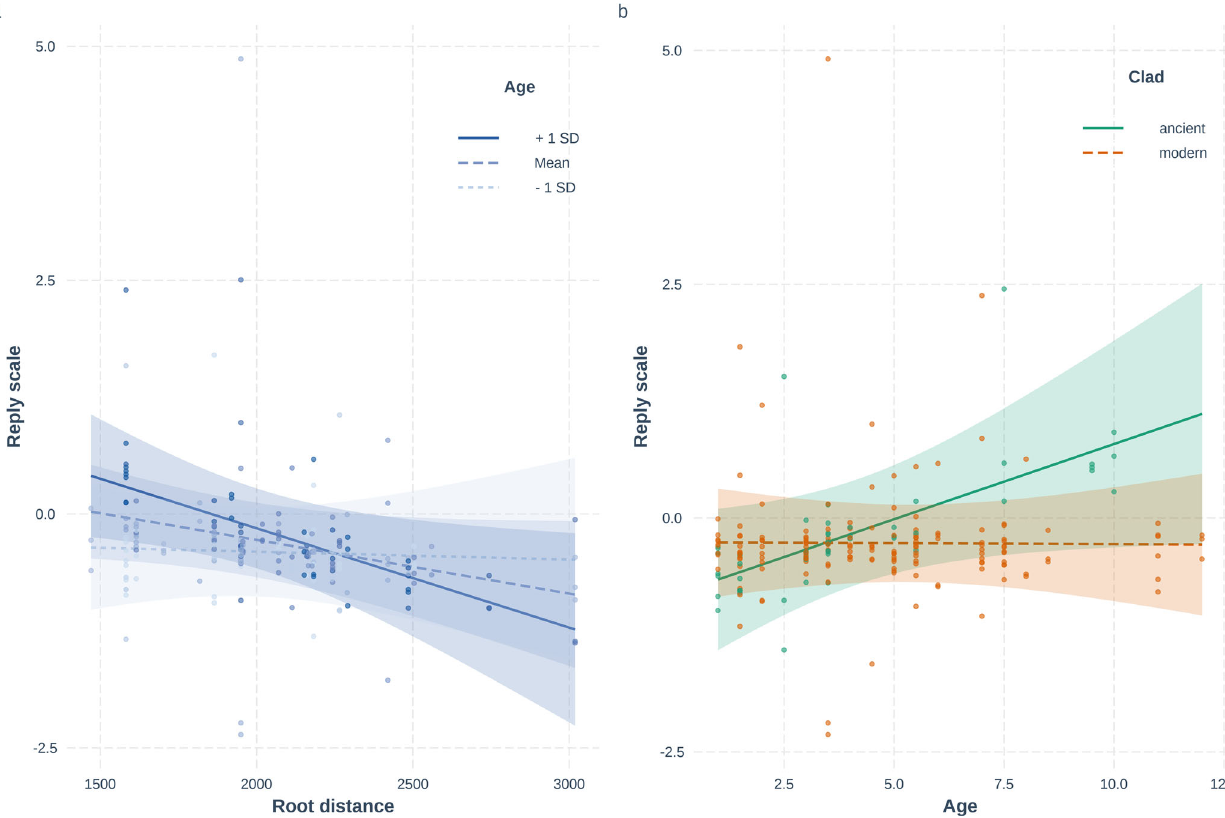
Fig. 1 Effect of the interaction of Root distance/Breed group and age on the Reply scores (howling moaning, yelping, and bark-howling response). In a , X -axis shows the values of breeds ’ genetic distance from wolves; the Y -axis shows the scores of the PCA factors, and the dots represent partial residuals, controlling for the effects of other variables in the model besides the plotted ones. The different types of lines represent the age categories: − 1SD = 1.89 years, mean = 4.56 years, + 1 SD = 7.23 years of age. In b , X -axis shows the age as a scaled variable, the Y -axis shows the scores of the PCA factors, and the dots represent the partial residuals from the model. The different types of lines represent the breed categories (ancient,